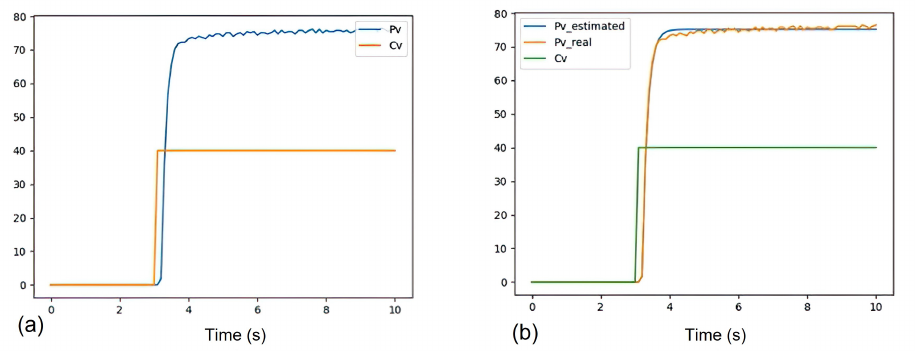
Figure 19. Chihai CHR-GM25 double quadrature motor from 140 RPM at 12 V within 10 s response. ( a ) Response of the motor to a step function (process variable v p ). ( b ) Approximation of v p by PSO.